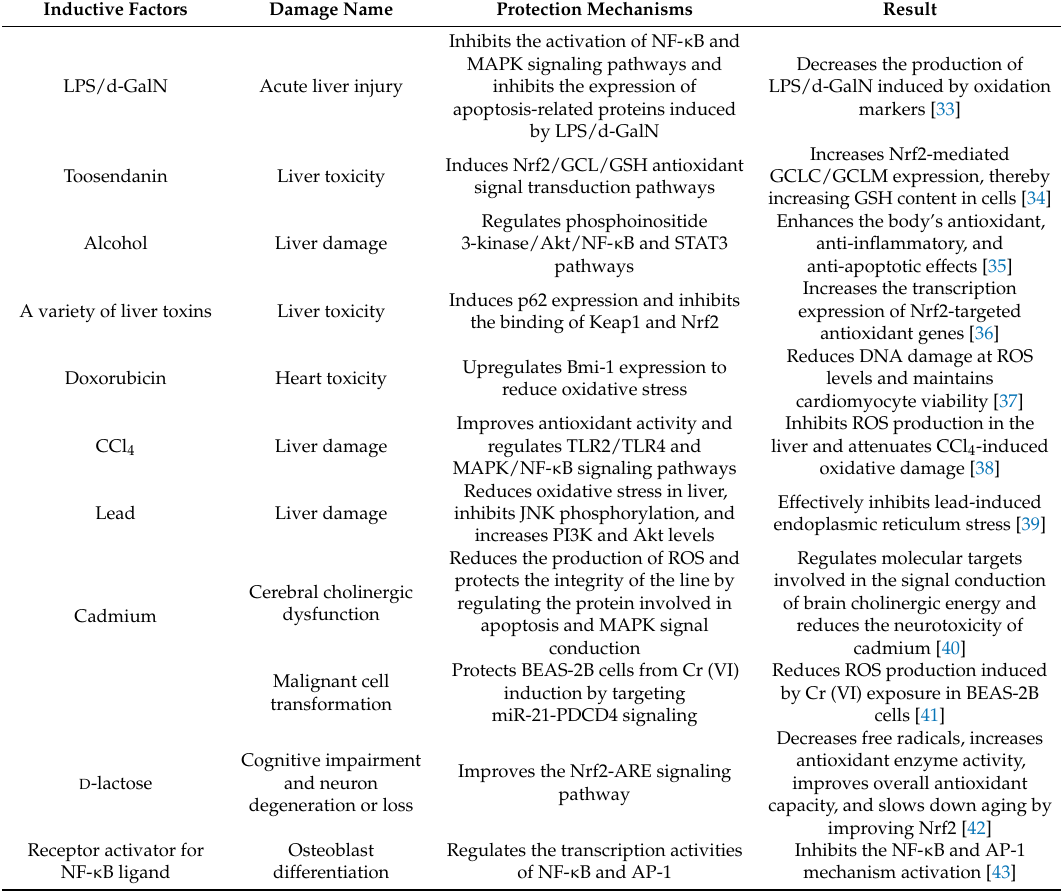
Table 1. Mechanisms of quercetin for treating damage induced by various